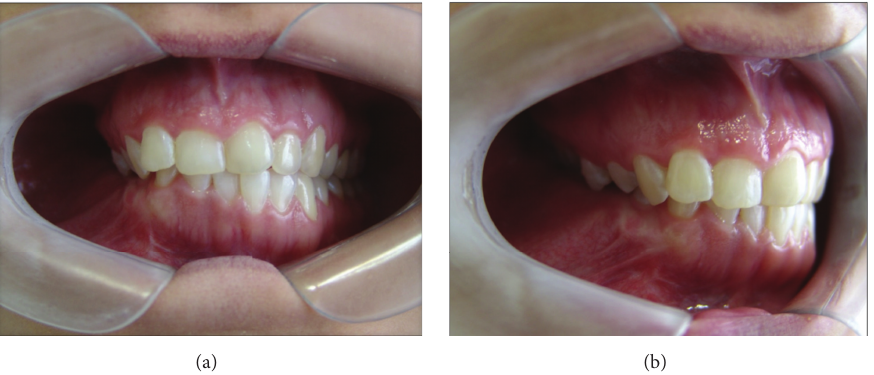
Figure 6: (a) Anterior and (b) anterolateral view of the intraoral region showing an increase in the alveolar ridge in the right hemimandible.